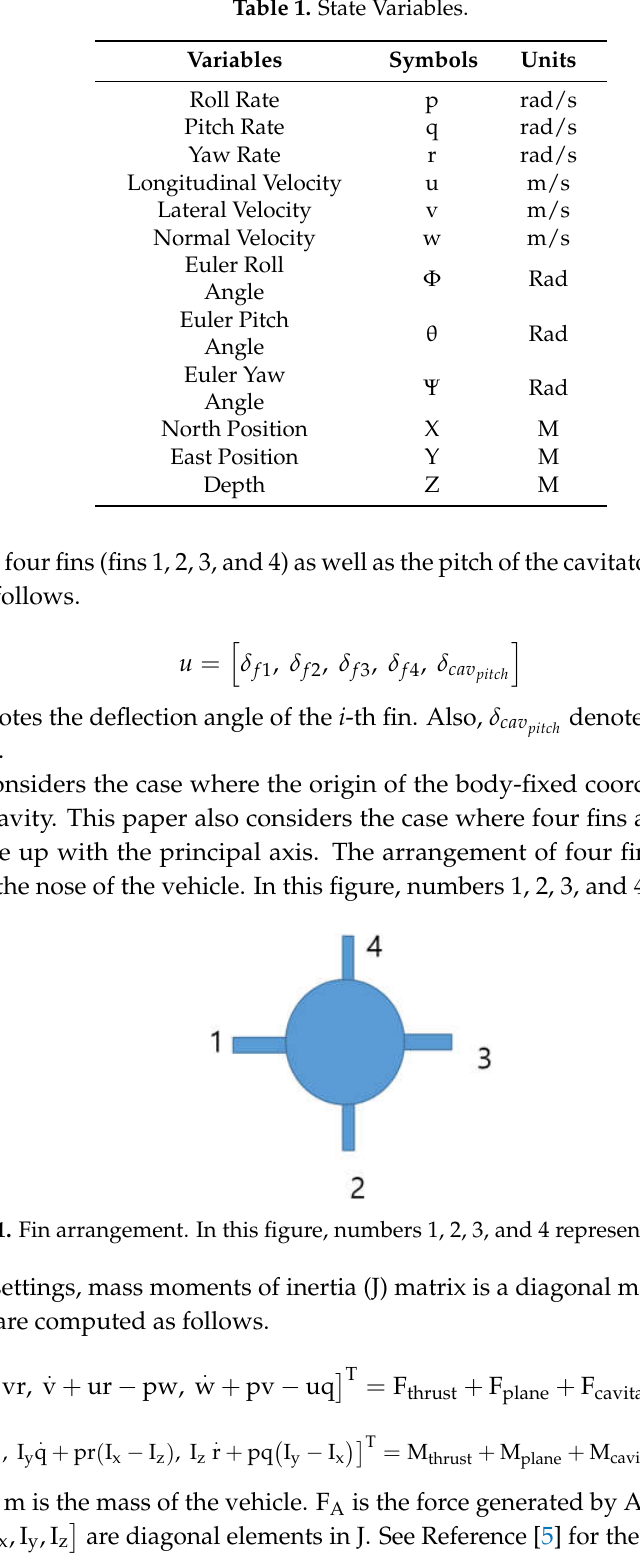
Table 1. State Variables.